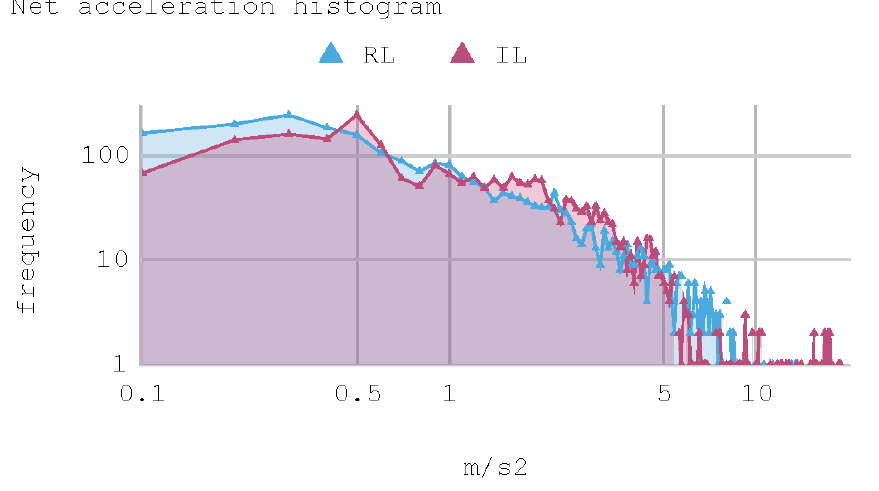
Figure 17. Case 2. Histogram of net acceleration on test tracks.